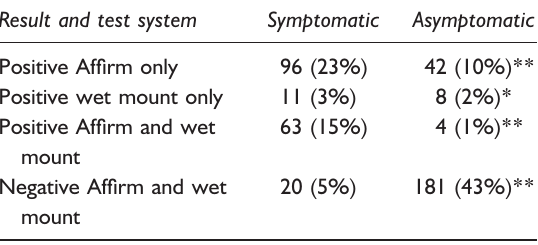
Table 2 Patients positive for Gardnerella , Candida , and/or Trichomonas versus the presence of symptoms for each test